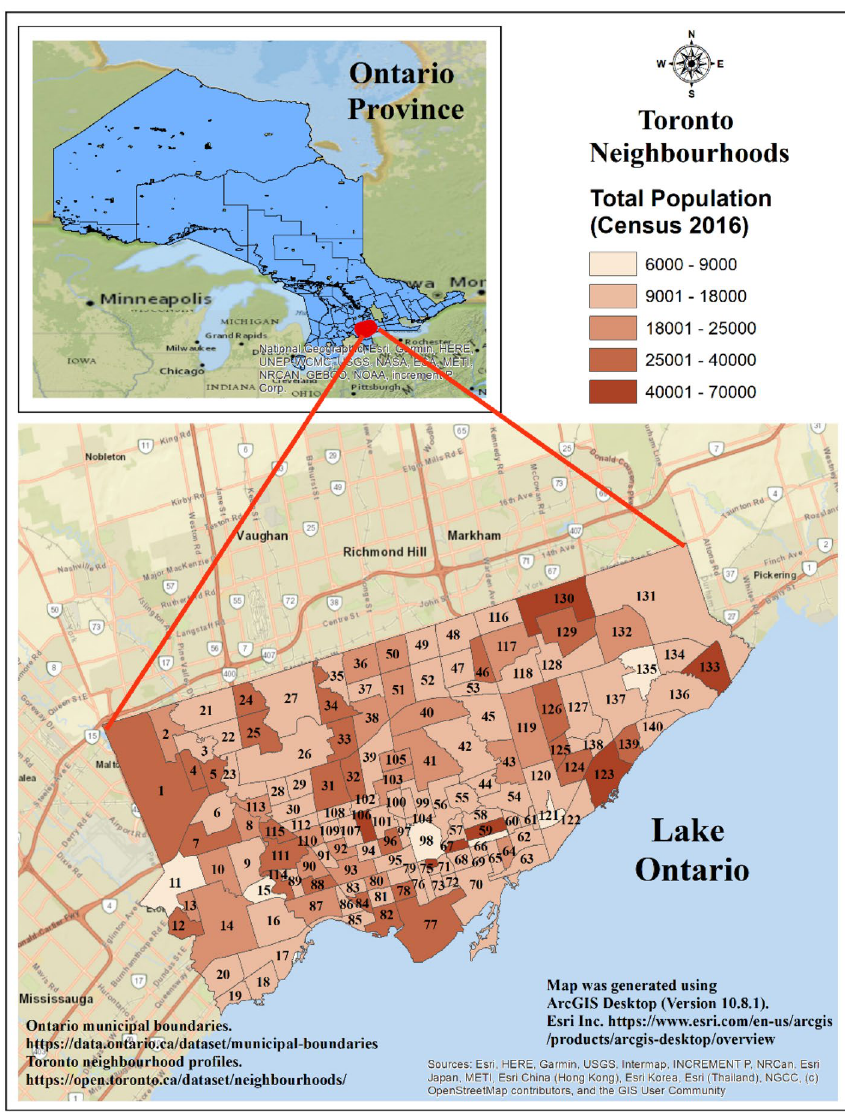
Figure 1. Study area in Toronto, Ontario, Canada. The numbers inside the neighbourhoods represent the neighbourhood